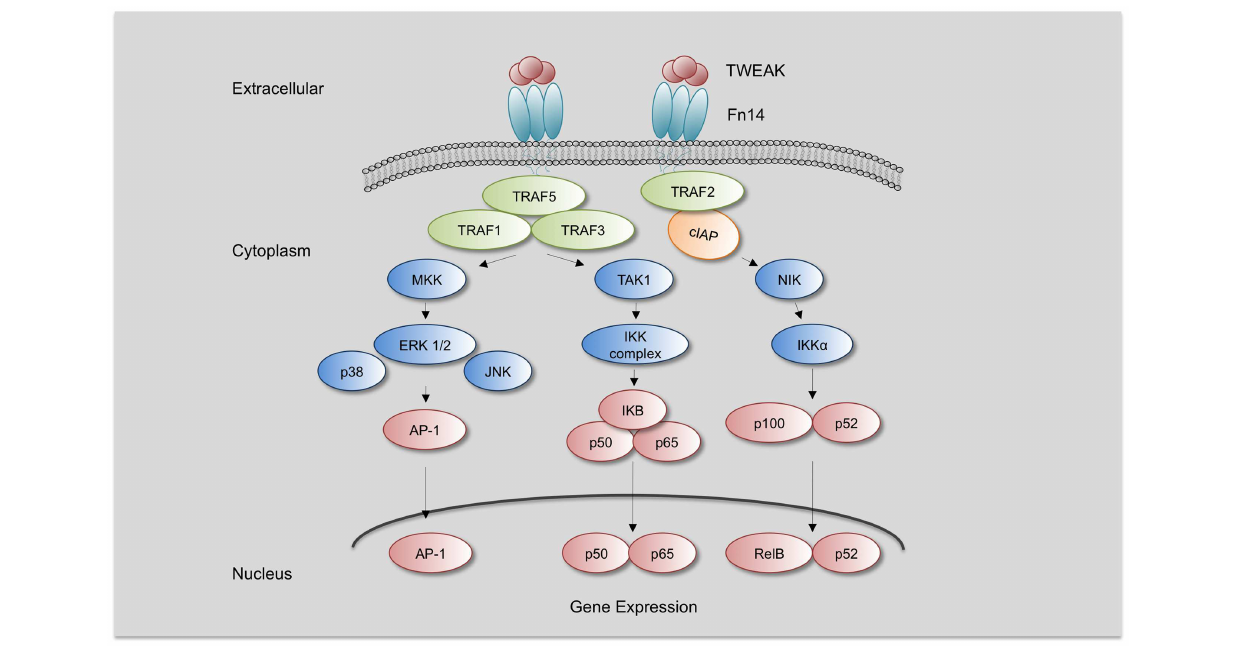
FIGURE 1 |TWEAK/Fn14 Signaling .TWEAK/Fn14 binding induces the recruitment of cIAP andTRAF-1, 2, 3, and 5 and leads to activation of different kinases such as mitogen-activated protein kinase kinases (MKK), transforming growth factor β -activated kinase 1 (TAK1), and NF- κ B inducing kinase (NIK). TAK1 activates IKK β and NIK activates IKK α , leading to the activation of